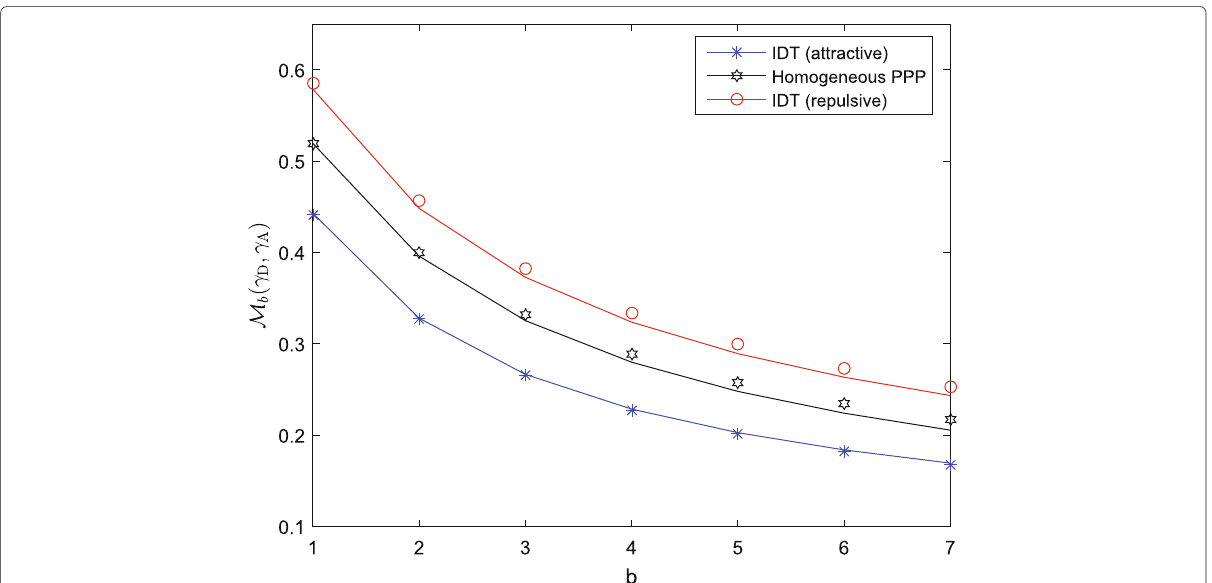
Fig. 1 Moments of the conditional coverage probability. Setup: General case. Solid lines: Monte Carlo simulations. Markers: IDT framework